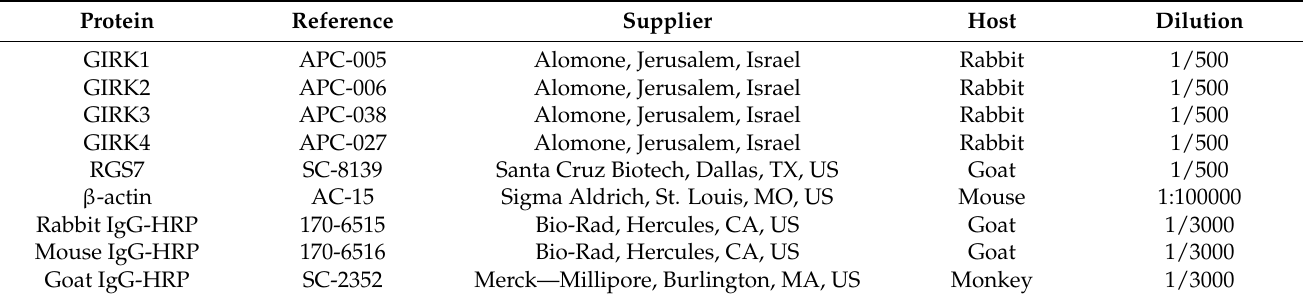
Table 1. Characteristics of primary and secondary antibodies used to measure protein expression by Western